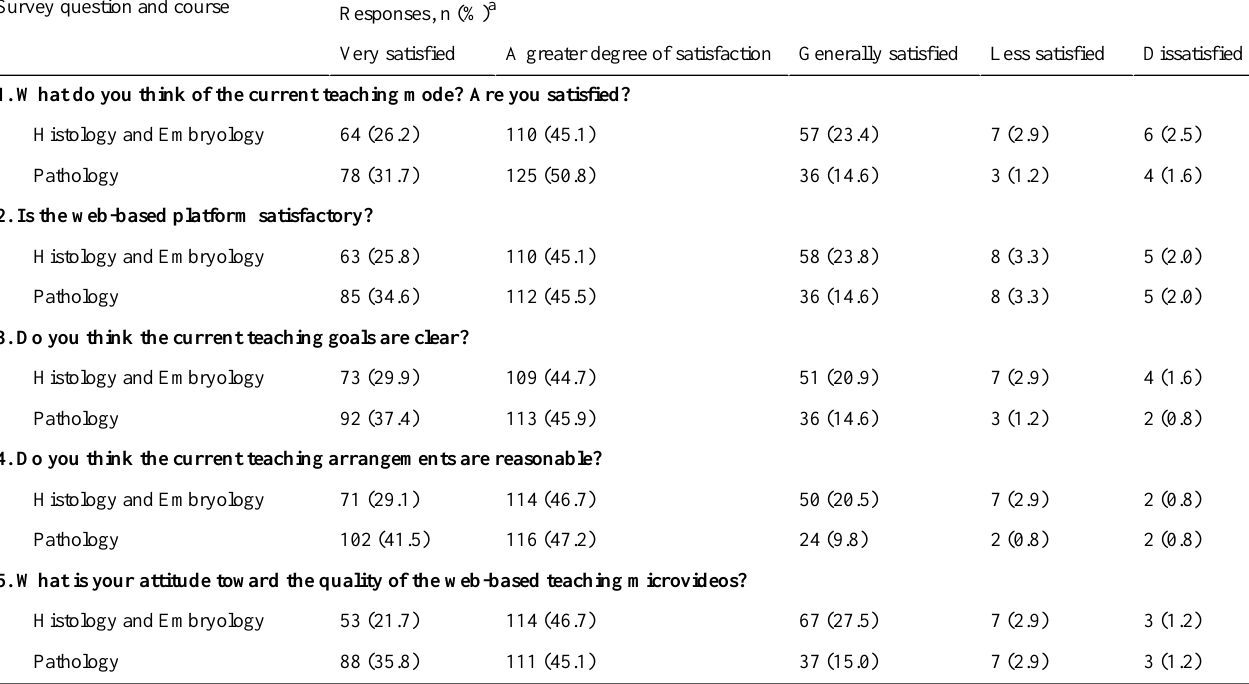
Responses, n (%) a Survey question and course